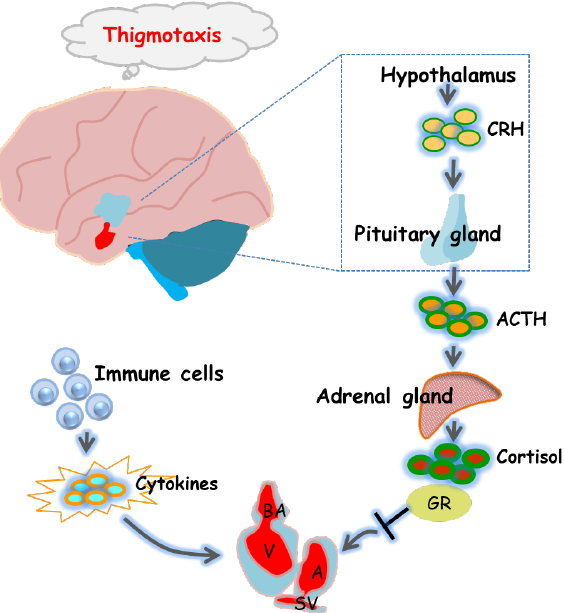
Figure 6. Diagram of the underlying mechanisms by which 6-BA affects zebrafish heart formation and function. 6-BA led to a defective cardiac phenotype that prevented cardiac morphogenesis, allowing abnormal cardiac cyclization and reduced cardiac contractility, thereby affecting cardiac function. In addition, mRNA levels of HPA-axis-related genes and cortisol levels differed significantly compared with controls, which was consistent with the anxious behavior observed in zebrafish at 3 dpf. Signature cytokines of the inflammatory response were also altered by 6-BA induction. In general, the study found that 6-BA induced cardiotoxicity in zebrafish, which may be related to the change of HPA axis activity and the occurrence of inflammatory response under 6-BA treatment.